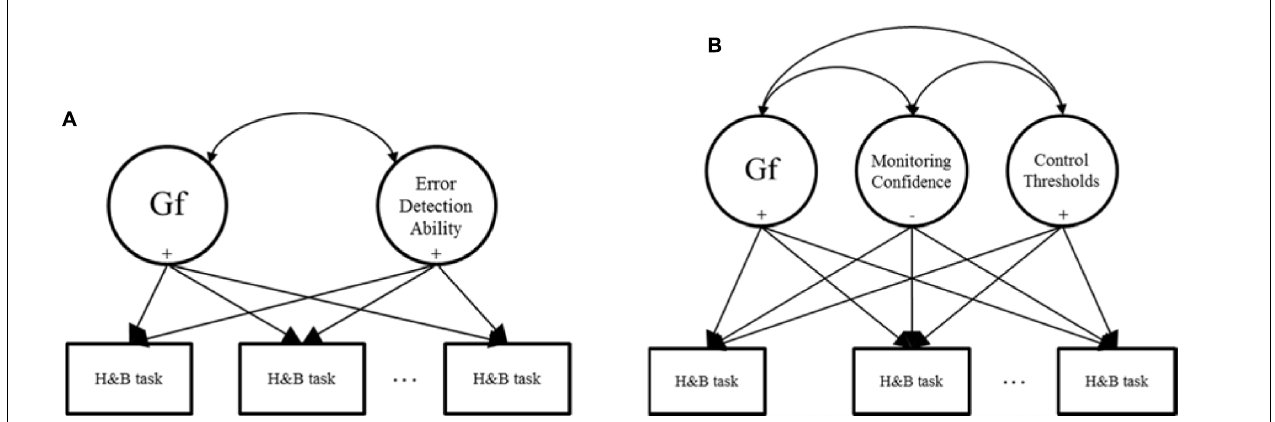
FIGURE 1 | Models used for predicting individual differences in heuristic and biases (H&B) tasks. (A) Represents existing approaches; (B) represents the approach adopted in this research.